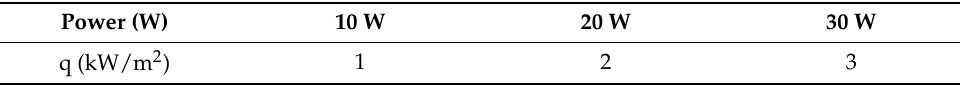
Table 3. Power values and their heat fluxes.